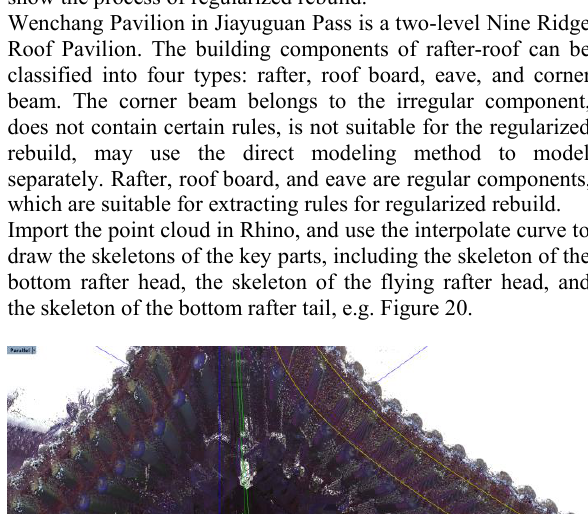
Figure 19. Cascade round-ridge roof